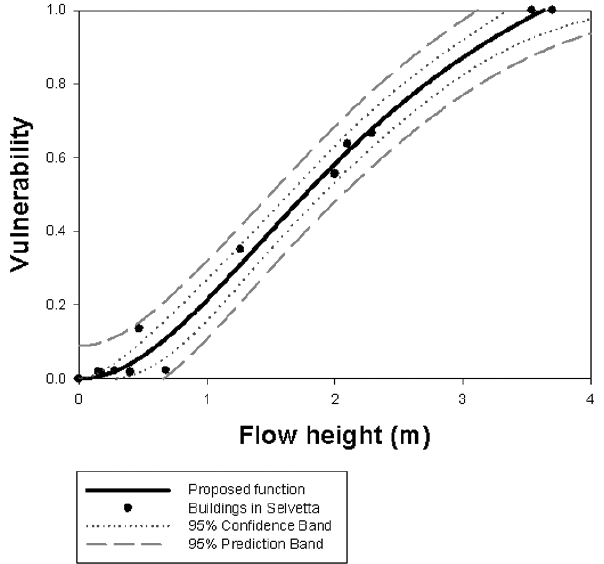
Fig. 8. Proposed vulnerability function for accumulation heights obtained from the modelling.